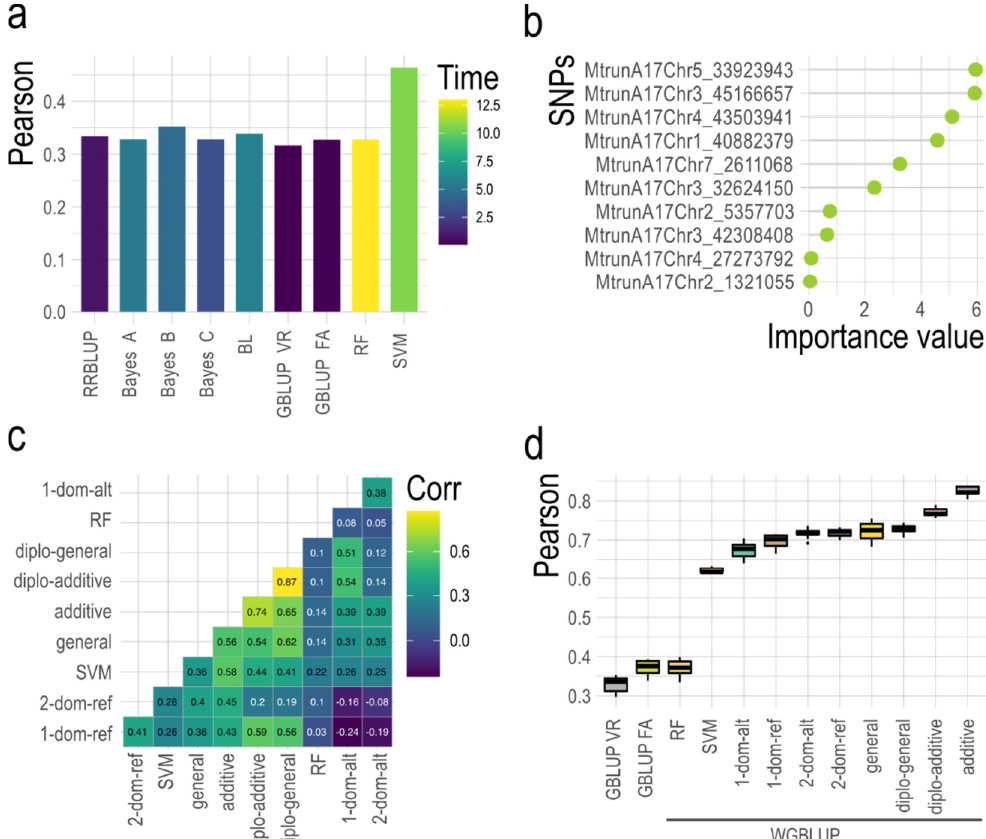
Figure 2. Optimization of GS models. ( a ) GS model accuracy measured as Pearson’s correlation after 10-fold cross-validation for biomass yield under salt stress. Computing time was measured as system time in seconds to run one cross-validation. ( b ) Example of variable importance values derived from SVM for 10 randomly chosen SNPs. ( c ) Pearson’s correlation for 6796 SNPs weights obtained by variable importance (SVM, RF) or by − log 10 p -values of different GWASpoly models. ( d ) Accuracy of GBLUP (GBLUP VR and GBLUP FA) and WGBLUP models. Accuracy was measured 10 times using Pearson’s correlation with 10-fold cross-validation. SNP weights for WGBLUP were obtained from variable importance values (SVM, RF) or − log 10 p -values of different GWASpoly models. RRBLUP, best linear unbiased prediction using ridge-regression; BL Bayes LASSO; GBLUP, genomic best linear unbiased prediction; VR, VanRaden G matrix; FA, full autotetraploid G matrix; RF, random forest; SVM, support vector machine; WGBLUP, weighted GBLUP; 1-dom-alt and 1-dom-ref, simplex dominant models; 2-dom-alt and 2-dom-ref, duplex dominant models; diplo-general, diploidized general; diplo-additive, diploidized